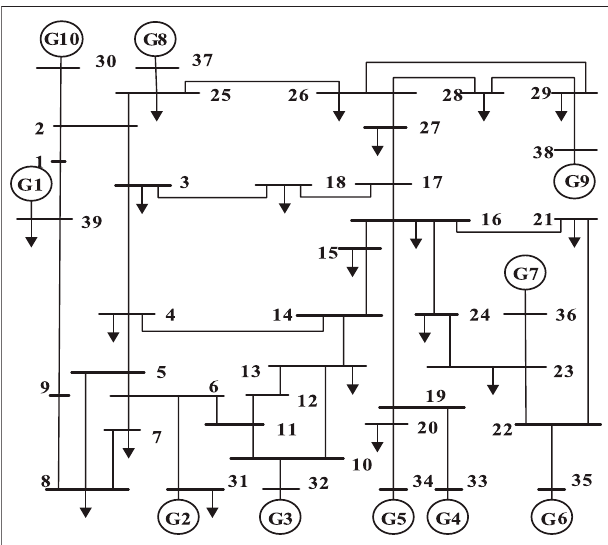
FIGURE 5 | One-line diagram of the New-England 39-bus system.